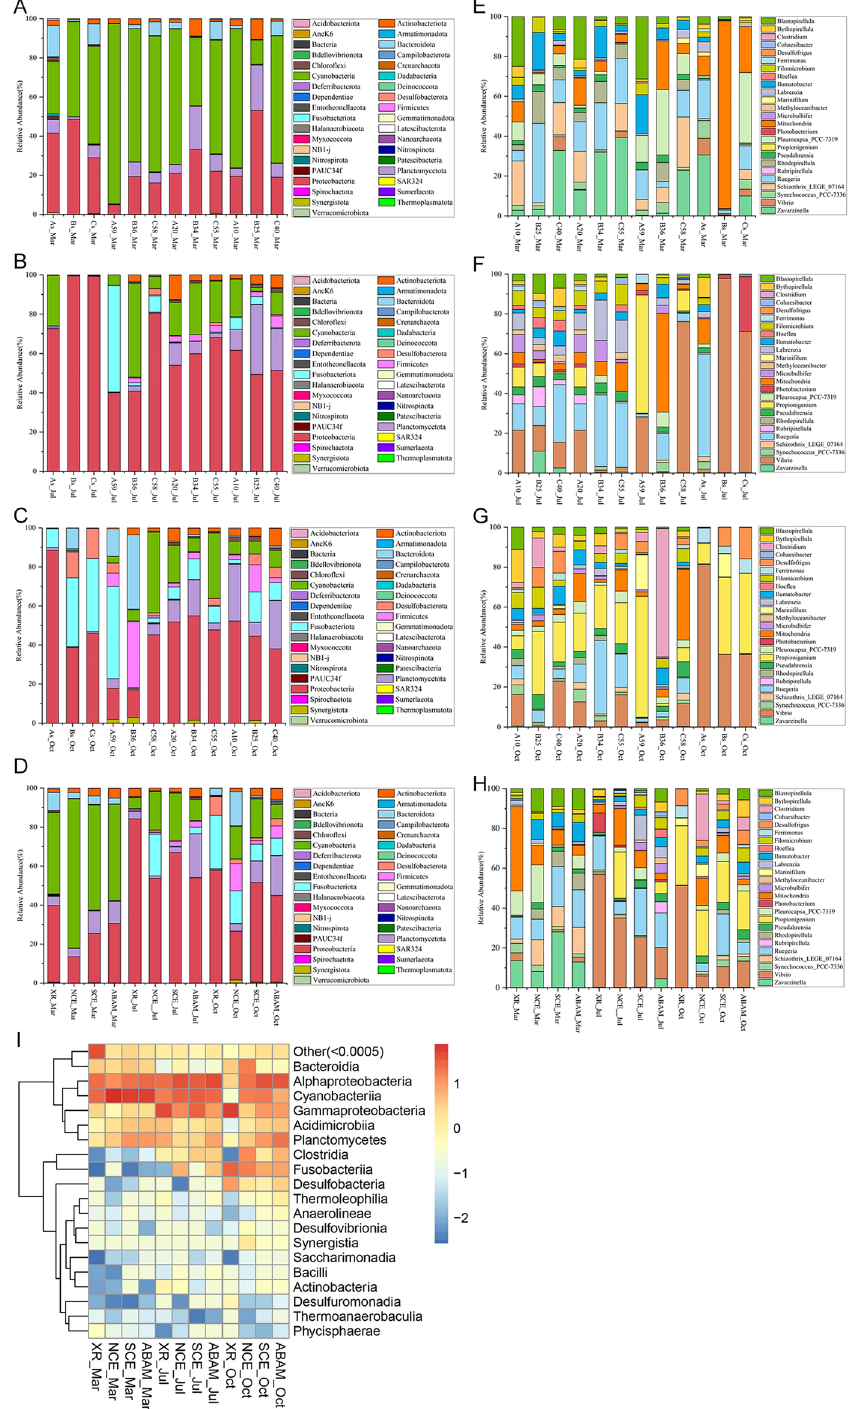
Figure 3. Venn diagrams, representing unique and shared microbial ASVs at 97% identity illustrating the distribution of bacterial taxa among different treatments gathered from data of the three sites in comparison to the natural reef samples over three